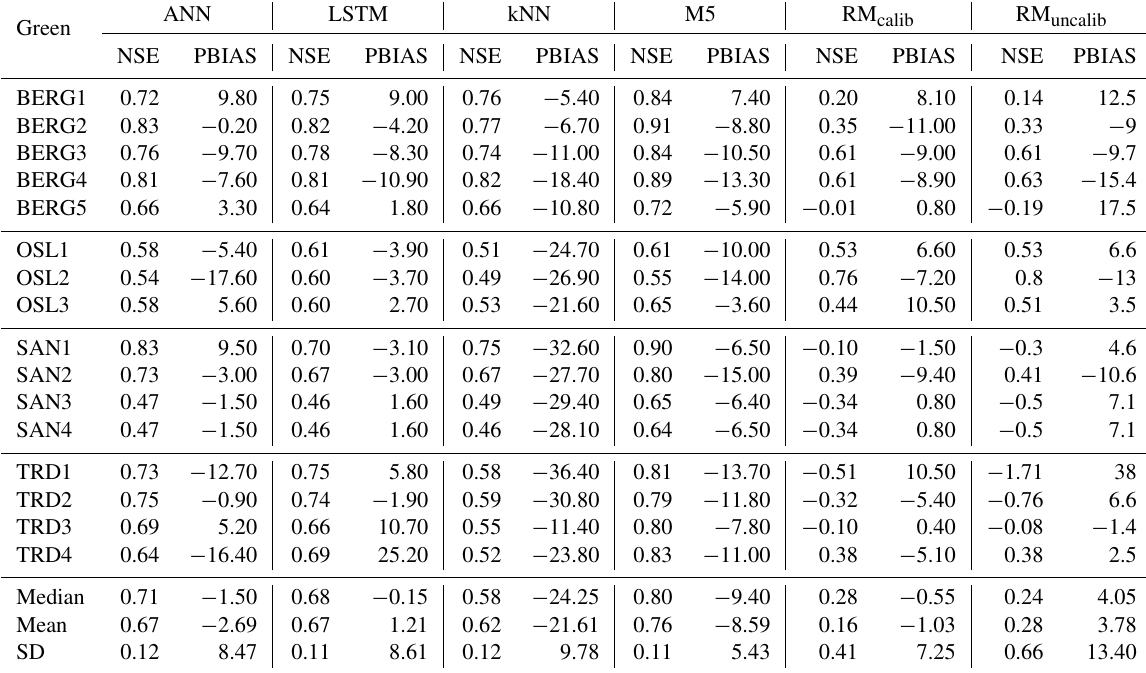
Table 5. Overall modelling performance (testing data).